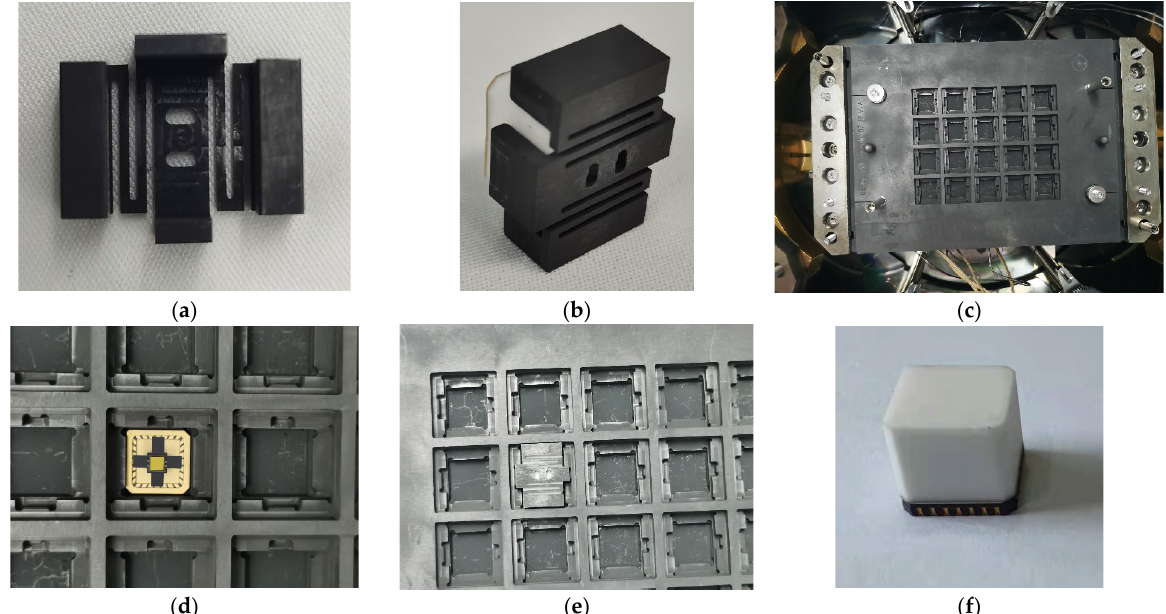
Figure 10. Photographs show the alignment configuration during vacuum packaging. ( a ) The photograph of the top plate; ( b ) the photograph shows that the ceramic shell is loaded on the top plate; ( c ) the photograph shows the middle plate on the bottom plate; ( d ) the photograph shows that Part C is accommodated on the bottom plate; ( e ) the photograph shows the configuration of graphite fixture after alignment; ( f ) the photograph shows a physics package after vacuum packaging.